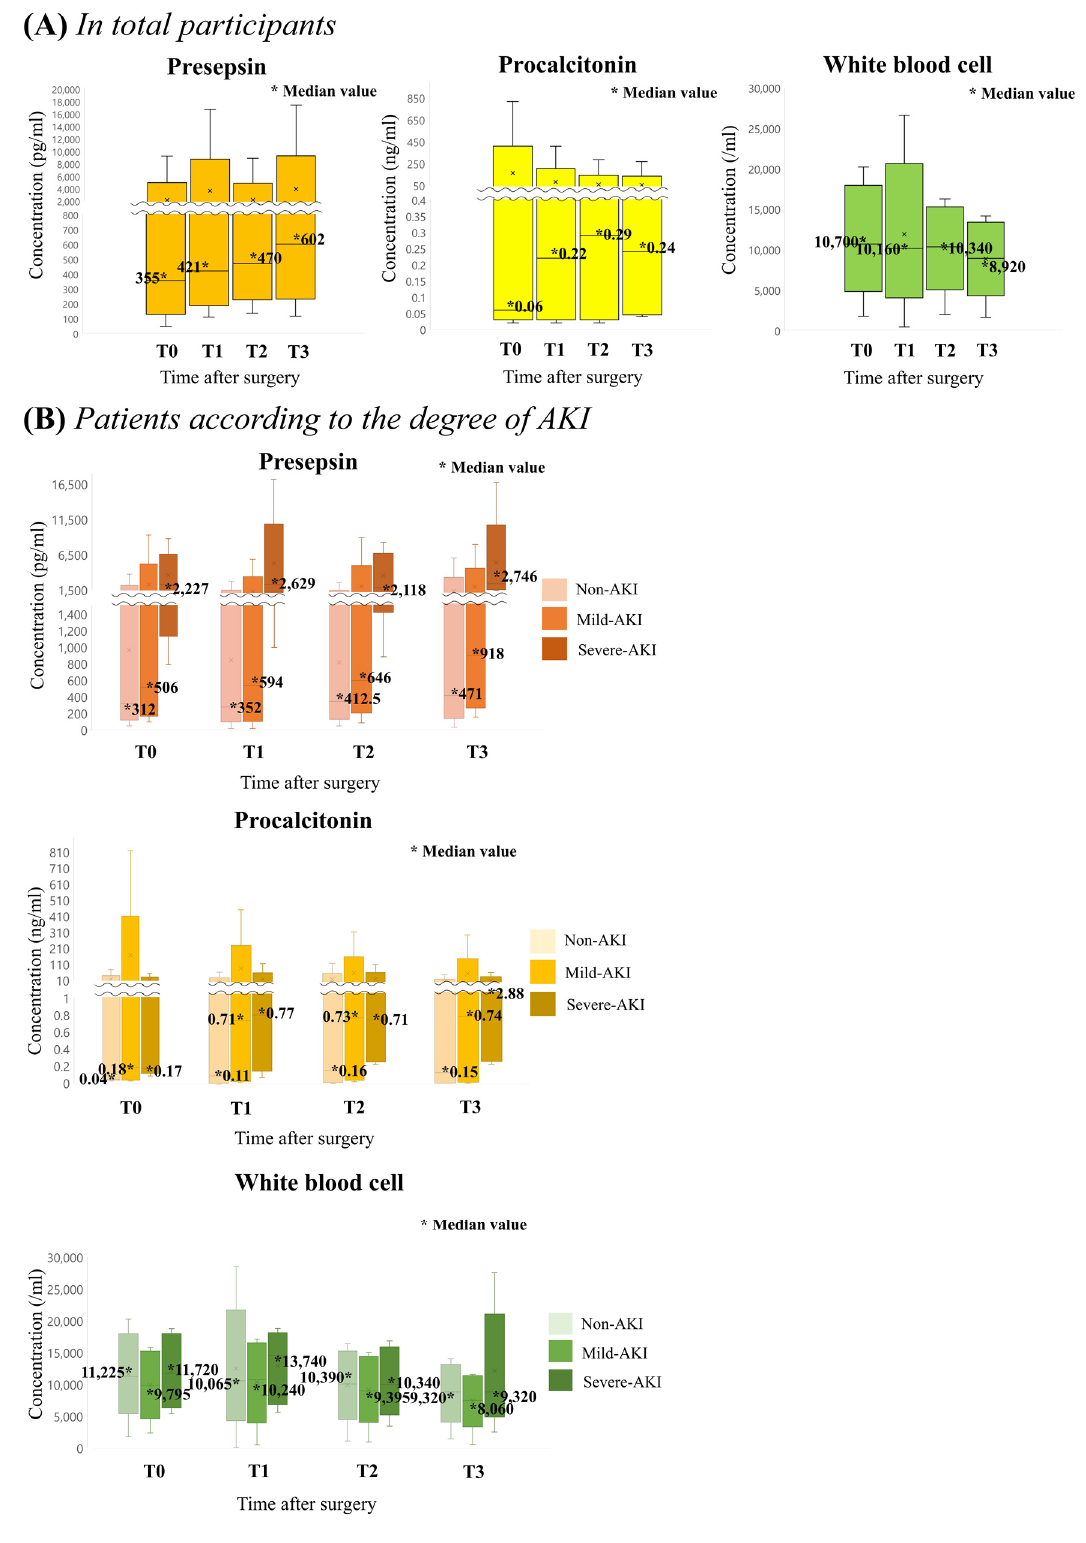
Figure 3. Comparison of median values of each inflammatory marker during observational period after surgery: ( A ) in total participants and ( B ) patients according to the degree of